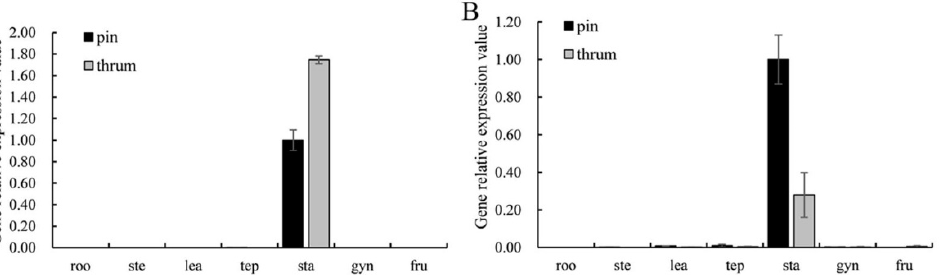
Figure 4. Expression of FaesPI_1 and FaesPI_2 in the root (roo), stem (ste), juvenile leaf (lea), tepal (tep), stamen (sta), gynoecium (gyn), and 6-day-old fruits (fru) were detected by qRT-PCR by using Faesactin as the internal control. ( A ) FaesPI_1 expression in seven organs of F. esculentum ; ( B ) FaesPI_2 expression in seven organs of F. esculentum.